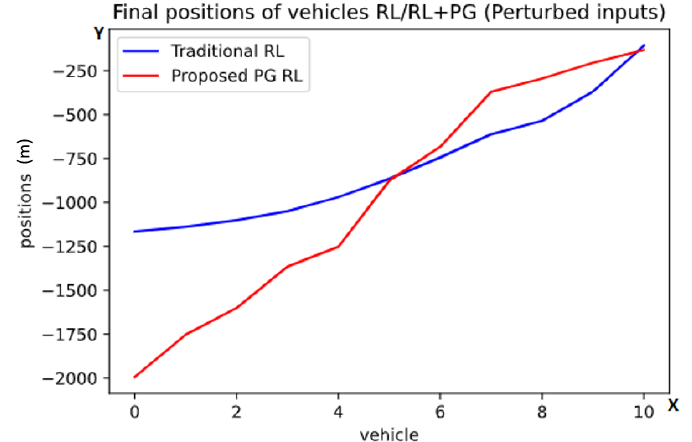
Figure 4. Graph of the finals positions after the first task with randomized inputs using the traditional RL (blue color) and the proposed PG RL (red color) models. The y -axis is representing the position behind the lead vehicle in meters while one point on the x -axis is referring to exactly one vehicle. These are the average final positions at the end of the scenarios, with the numbers referring to the vehicles (from back to